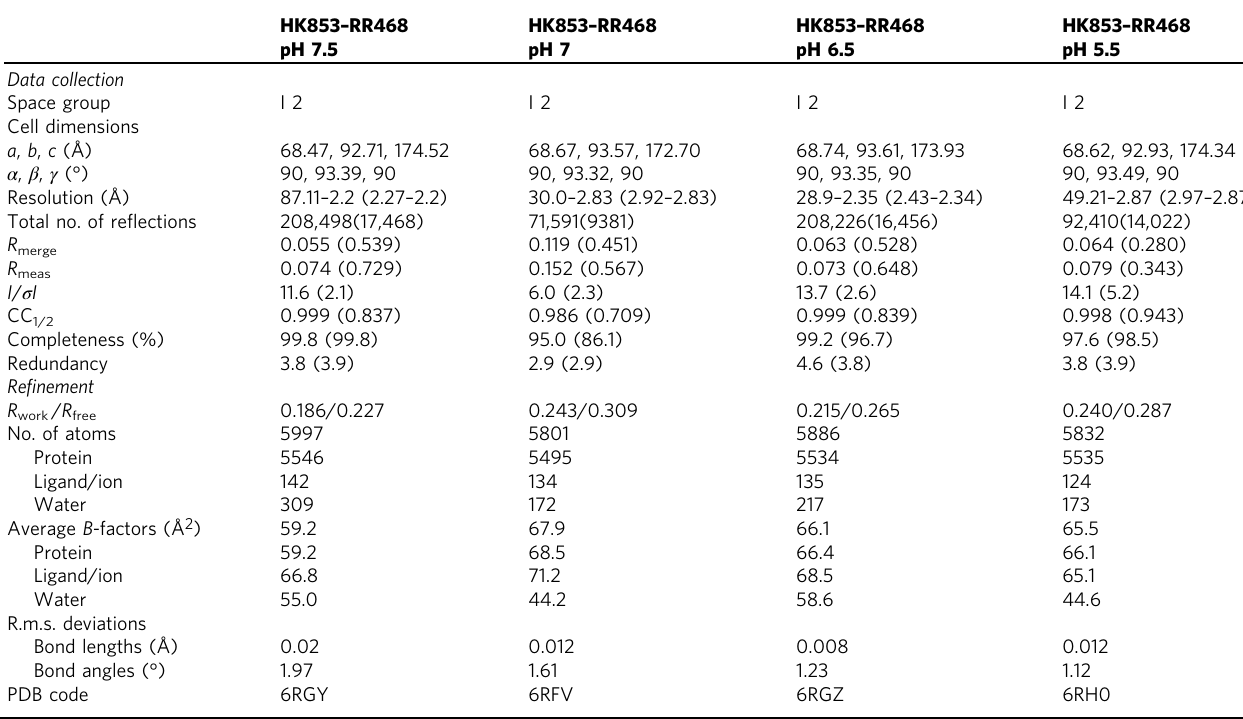
Table 2 Data collection and re fi nement statistics for HK – RR pHs structures.